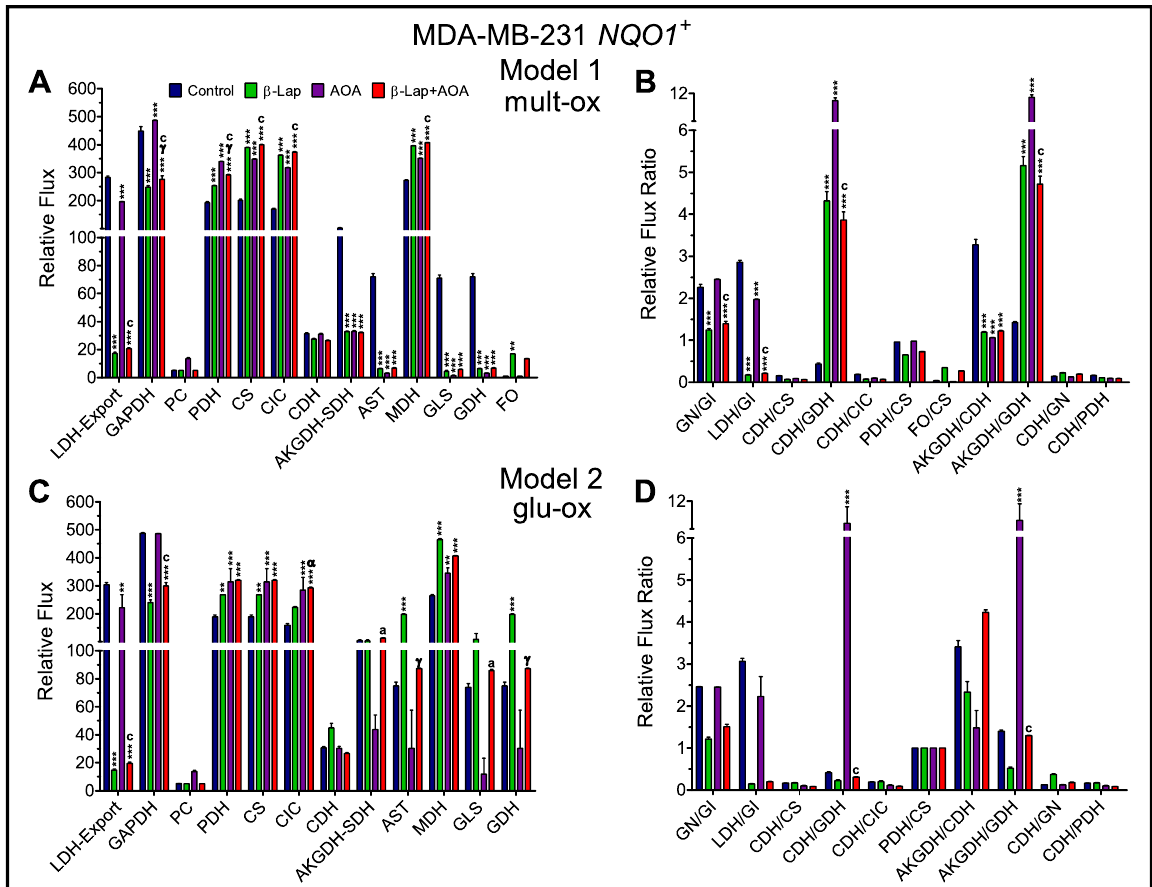
Figure 8. Analysis of metabolic flux in MDA-MB-231 NQO1 + cells. The relative net flux, as well as relative flux ratios, was assessed in two isotopomer network models. Model 1, mult-ox, (Panels ( A , B )) addresses central metabolic pathways and reactions, as well as branching pathways relevant to the mechanism of action. Model 2, glu-ox, (Panels ( C , D )) is a modified version of the first model that excludes fatty acid import and oxidation, which limits the contribution of unlabeled acetyl-CoA in the model. This alternative analysis infers greater GLS and GDH flux in β -lap-treated NQO1 + cells. Both models indicate β -lap treatment reroutes citrate out of the mitochondria to supply acetyl-CoA units. Differences in relative net flux values indicate a significant downregulation in glycolysis caused by β -lap as well as TCA cycle proper induced by both β -lap and AOA treatment in MDA-MB-231 NQO1 + cells. The relative flux ratios highlight significant decrements in glycolysis as well as the breakdown of the forward TCA cycle flux caused by β -lap action in NQO1 + cells. Abbreviation of metabolic reactions: lactate dehydrogenase (LDH), lactate export (Ex- port), glyceraldehyde-3-phosohate dehydrogenase (GAPDH), pyruvate carboxylase (PC), pyruvate dehydrogenase (PDH), citrate synthase (CS), mitochondrial citrate carrier (CIC), citrate dehydroge- nase (CDH), α -ketoglutarate dehydrogenase (AKGDH), succinate dehydrogenase (SDH), aspartate aminotransferase (AST), malate dehydrogenase (MDH), glutaminase (GLS), glutamate dehydroge- nase (GDH), and fatty acid oxidation (FO). (Note: n = 3, biological replicate data are represented as mean ± SEM. Statistical significance was determined by ANOVA and student’s t -test post hoc analysis and is presented as: (**) if p ≤ 0.01 and (***) if p ≤ 0.001 compared to control. ( α ) if p ≤